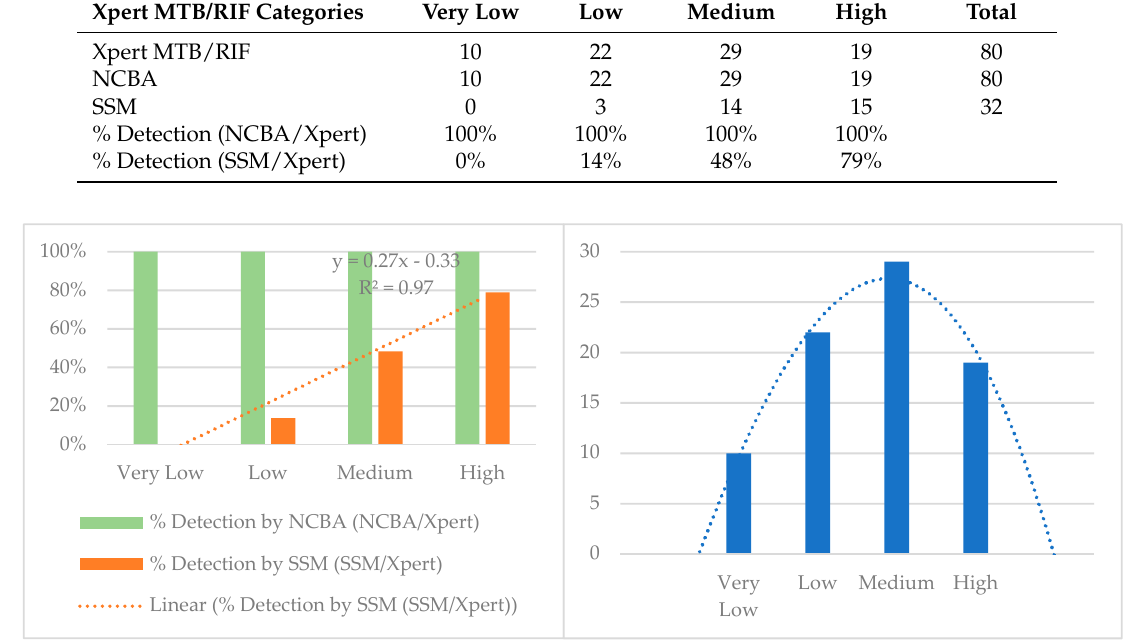
Figure 4. ( Left ) Percent detection by NCBA and SSM with respect to the Xpert MTB/RIF system. SSM detection increases linearly with acid-fast bacillus (AFB) concentration in the sputum sample. ( Right ) TB positive samples are normally distributed around the medium level.